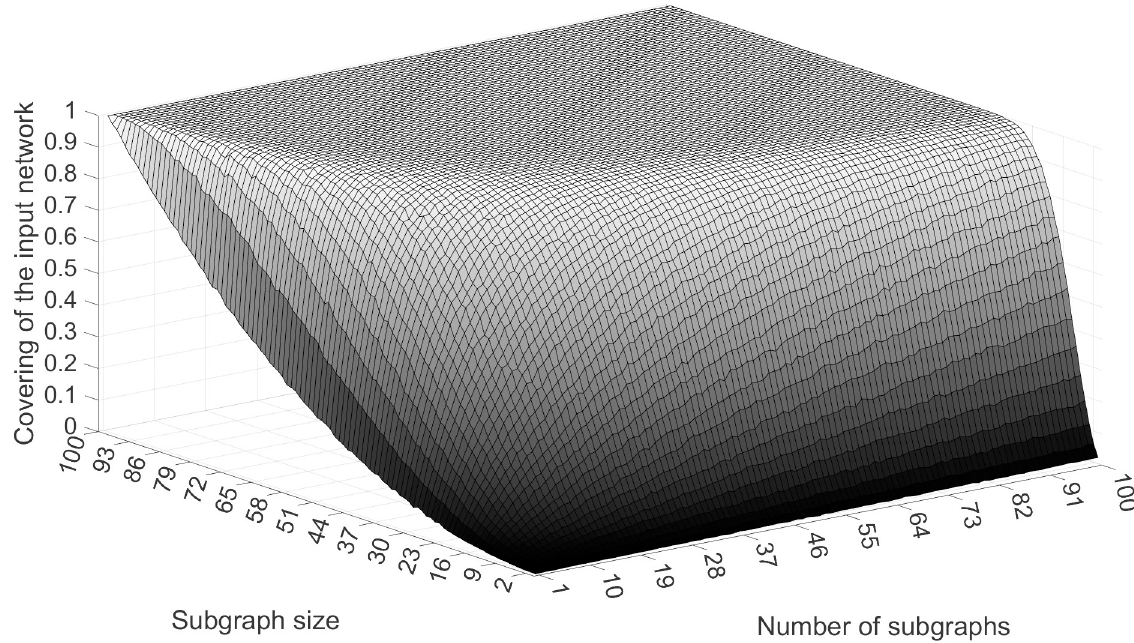
Fig 5. Relationship between the three key elements in the sampling process. X-axis, Y-axis and Z-axis are, respectively, the subgraph size, the number of subgraphs and the covering of the input data. The simulation was performed on an ER random network with 100 nodes and 1,000 edges. The mean value of the results across 10 runs is presented in the